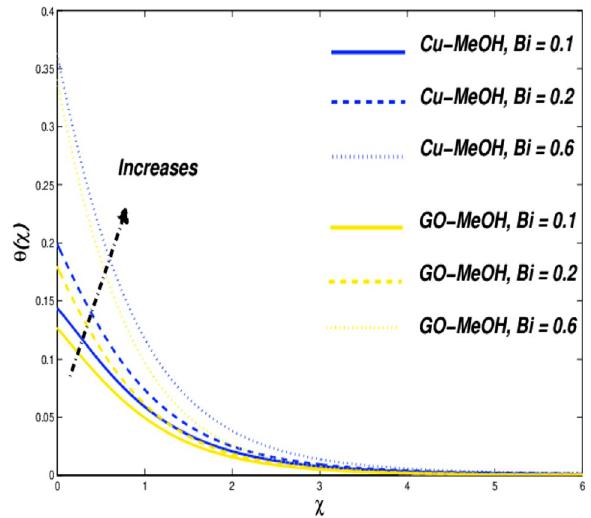
Figure 16. Temperature variation versus Bi .